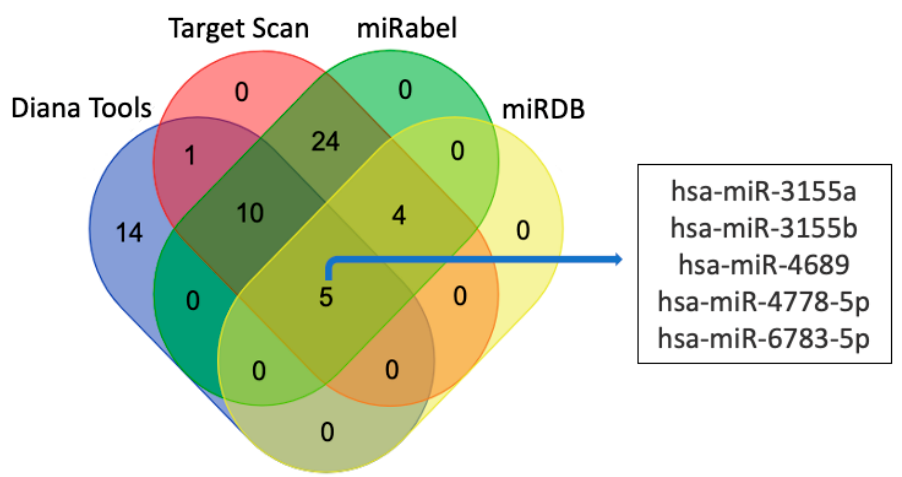
Figure 8. Putative miRNAs targeting LGALS16 mRNA transcript. Five miRNAs are unanimously predicted by four different online platforms such as Diana Tools, miRabel, miRDB, and TargetScan.